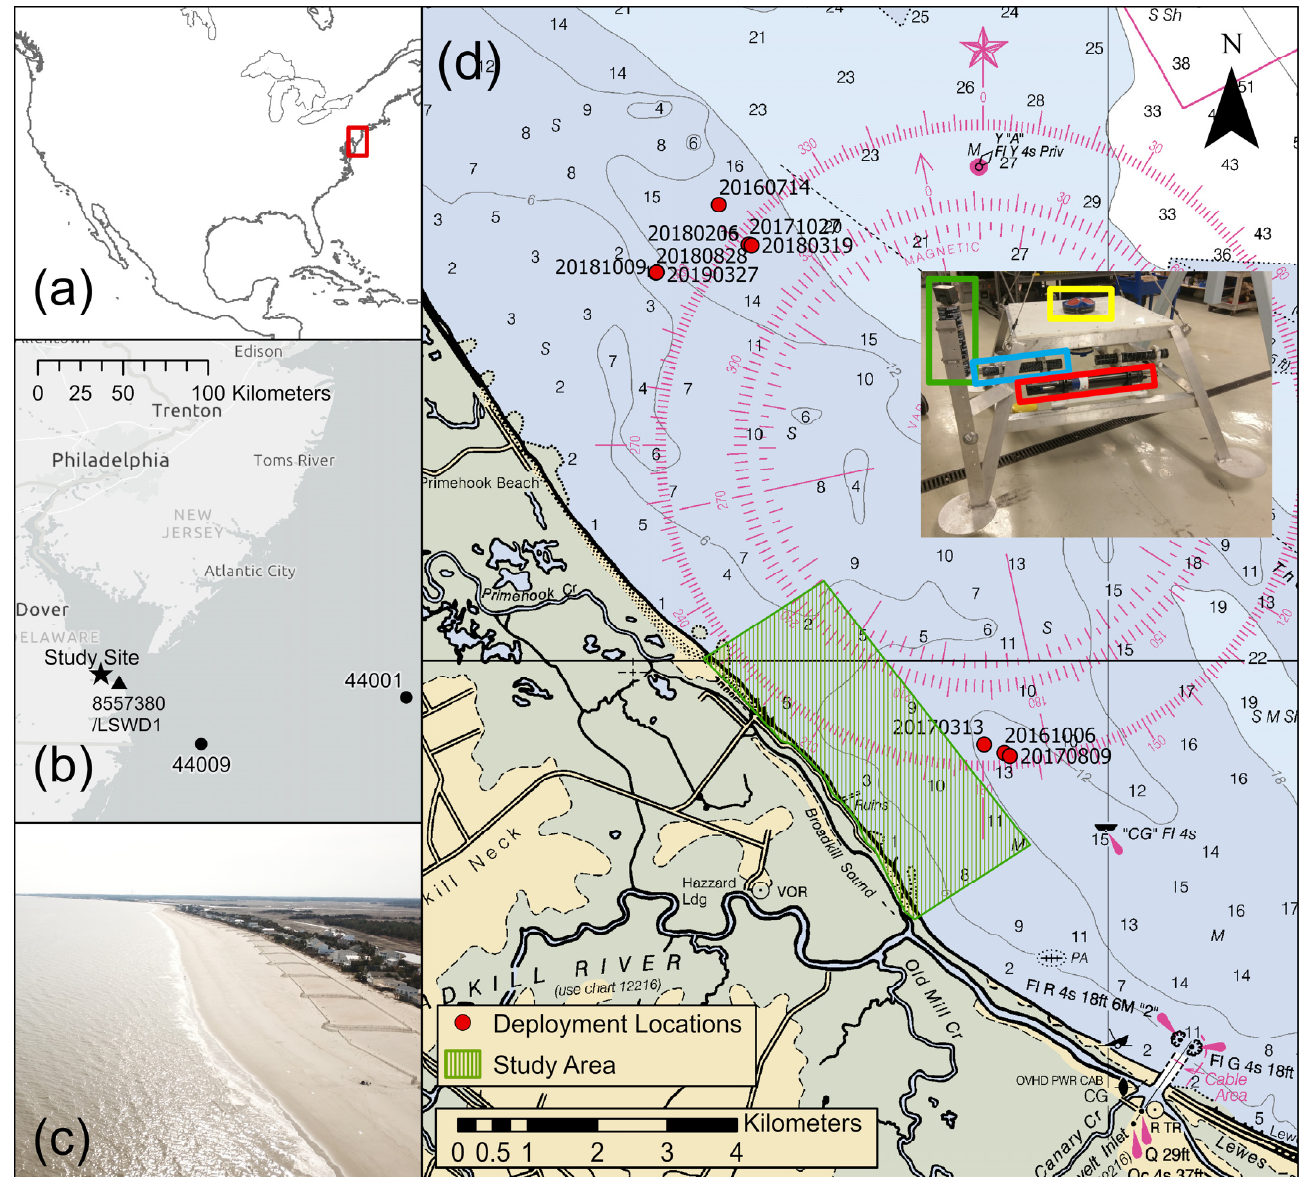
Figure 1. Study site characteristics: ( a ) outline of the United States with a red box outlining the DBE; ( b ) zoomed-in map of the DBE with the study site marked with a black star. NOAA wave buoys 44,009 and 44,001 are marked with black circles, while NOAA station 8557380/LSWD1 is marked with a black triangle. ( c ) UAS imagery (2018) from the center of the study site looking southward towards the bay entrance; ( d ) frame deployments (red circles) with dates and the survey area for the study site (green hashed box). Inlaid image of the acoustic frame with an upward-facing 600 kHz Teledyne RDI ADCP (yellow box), downward-facing 2 MHz Aquadopp HR Profiler (blue box), AML CTD with a turbidity sensor (red box), and an Imagenex 881 Rotary Sonar (green